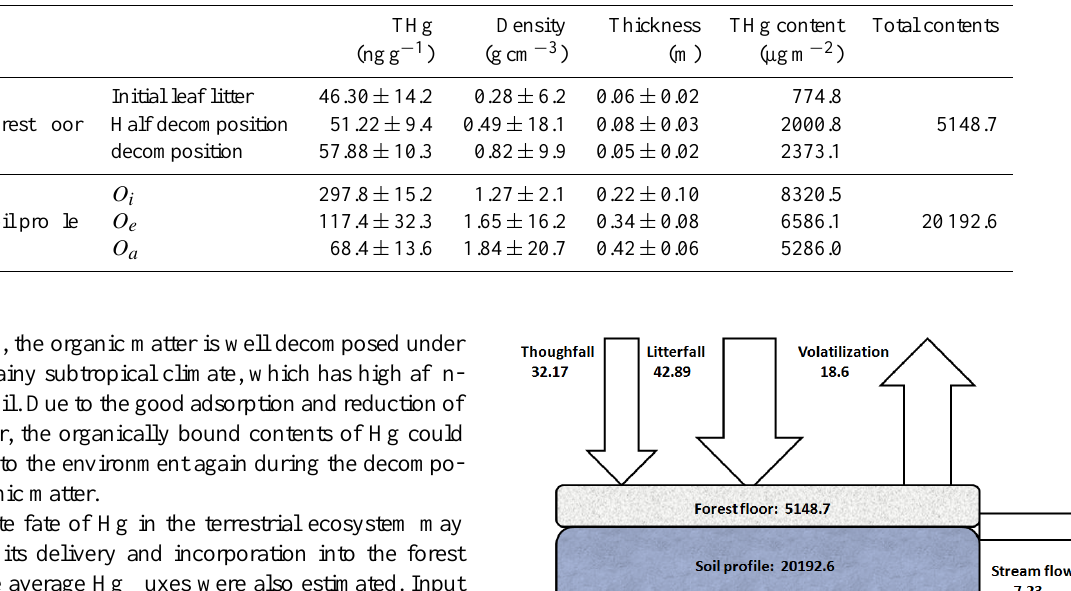
Table 2. The concentrations and contents of THg in forest floor and different soil layers.